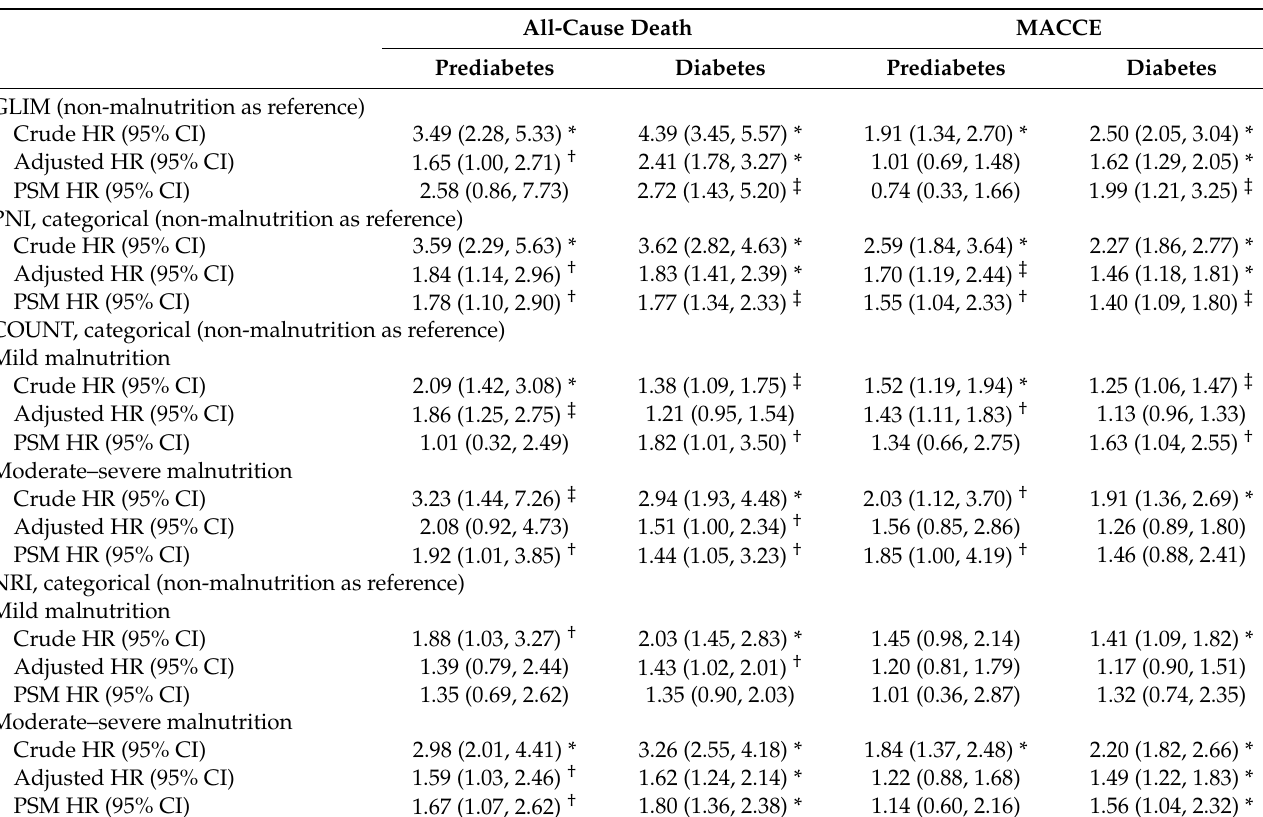
Table 3. Associations of malnutrition assessed by four assessment tools with all-cause death and MACCE, grouped by glycemic status. All-Cause Death MACCE Prediabetes Diabetes Prediabetes